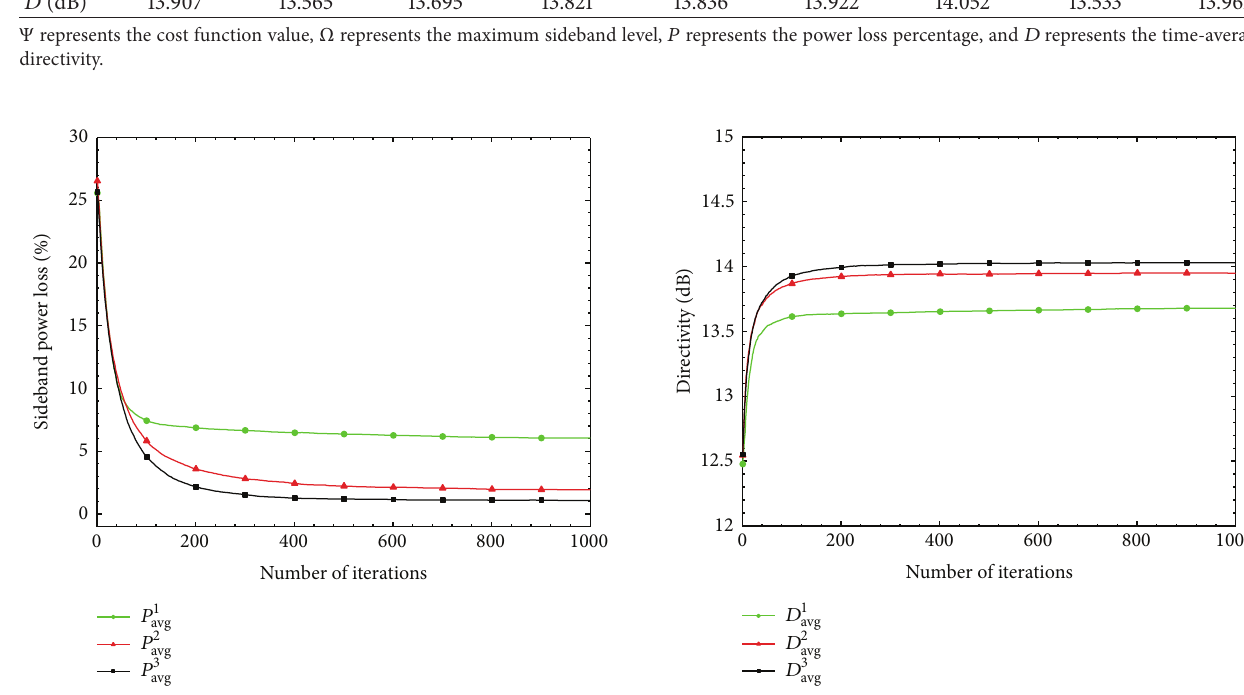
cost function value, the highest sideband level is produced by SB technique, and it is followed by SR and SBL,